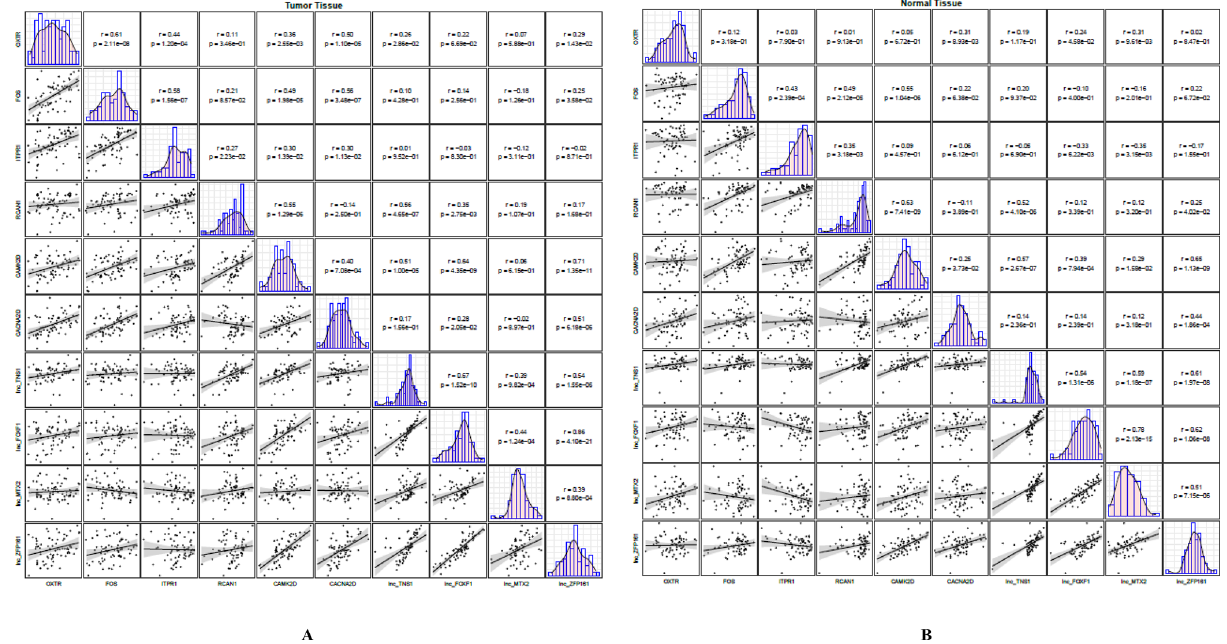
Figure 5. Correlations between expression levels of oxytocin-associated